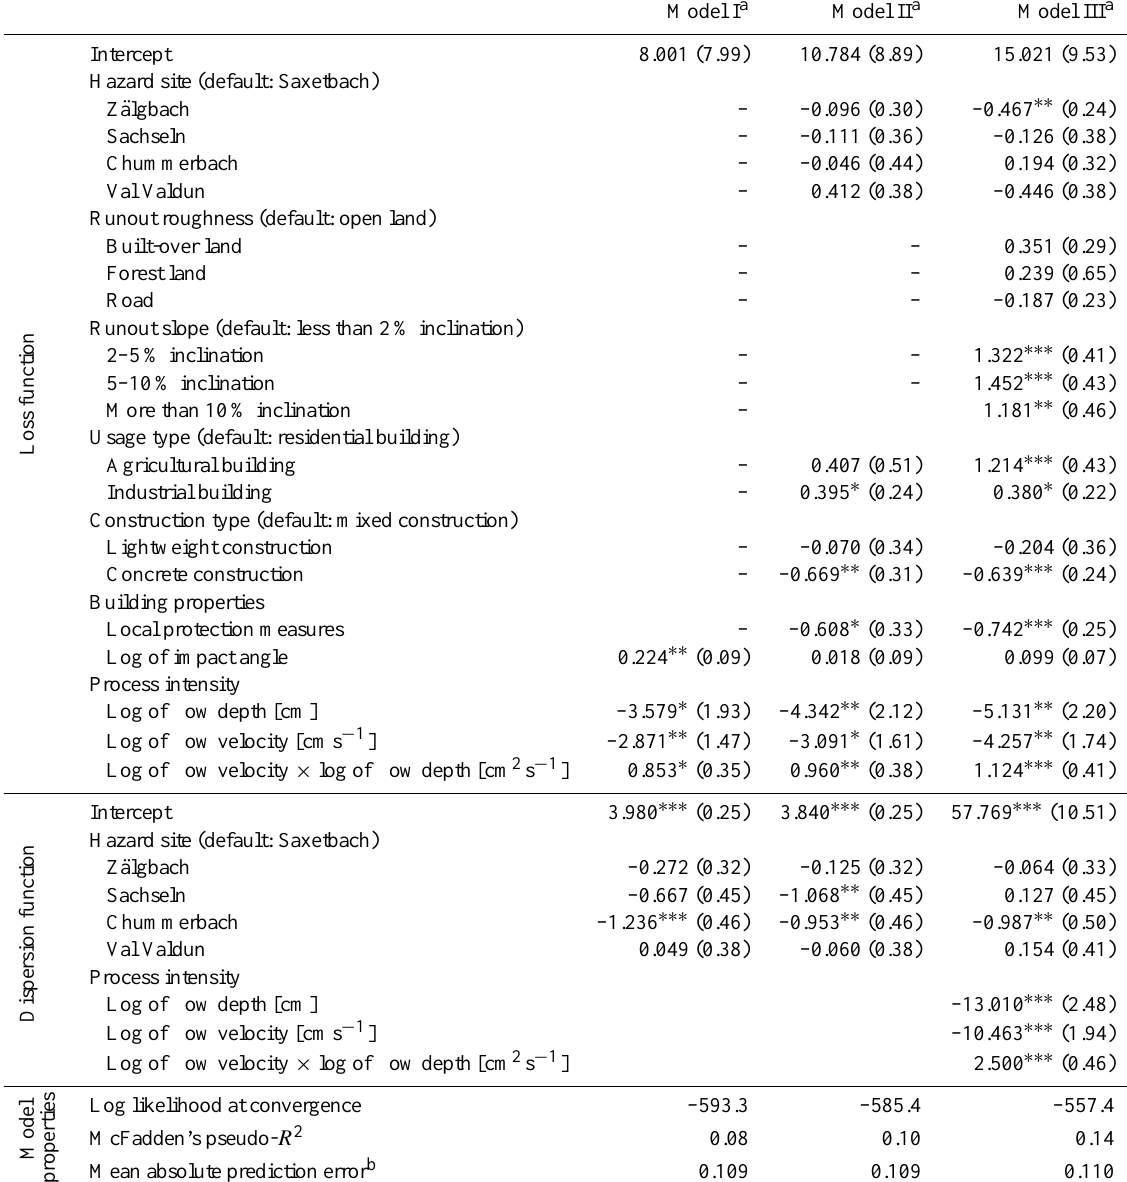
Table 2. Regression results of different DGLM specifications; standard errors are reported in